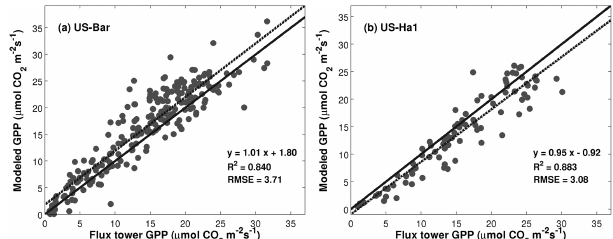
Figure 7. Regressions between modeled and measured GPP for 8 consecutive days at the sites (a) US-Bar and (b) US-Ha1. Data are from DOY 217 to 224 in 2004 for US-Bar and from DOY 241 to 224 in 2006 for US-Ha1. Only data during the photosynthetically active period (flux tower GPP >0.5µmolCO 2 m − 2 s − 1 ) are included in the regression. The solid lines denote the 1 : 1 lines, and the dashed lines denote the regression lines.